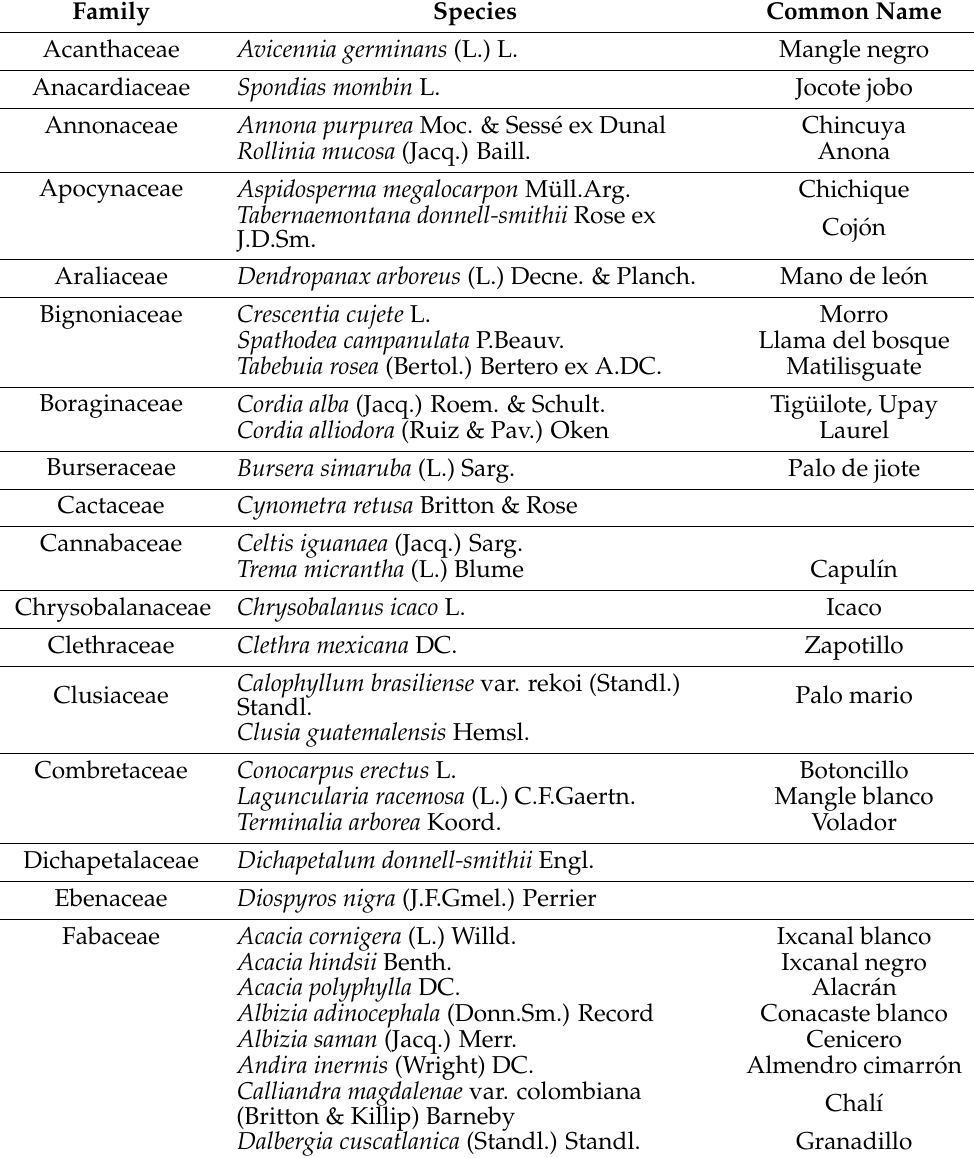
Table 1. Updated list of the tree species found in the Acom é riverbank (nomenclature following Angiosperm Phylogeny Group